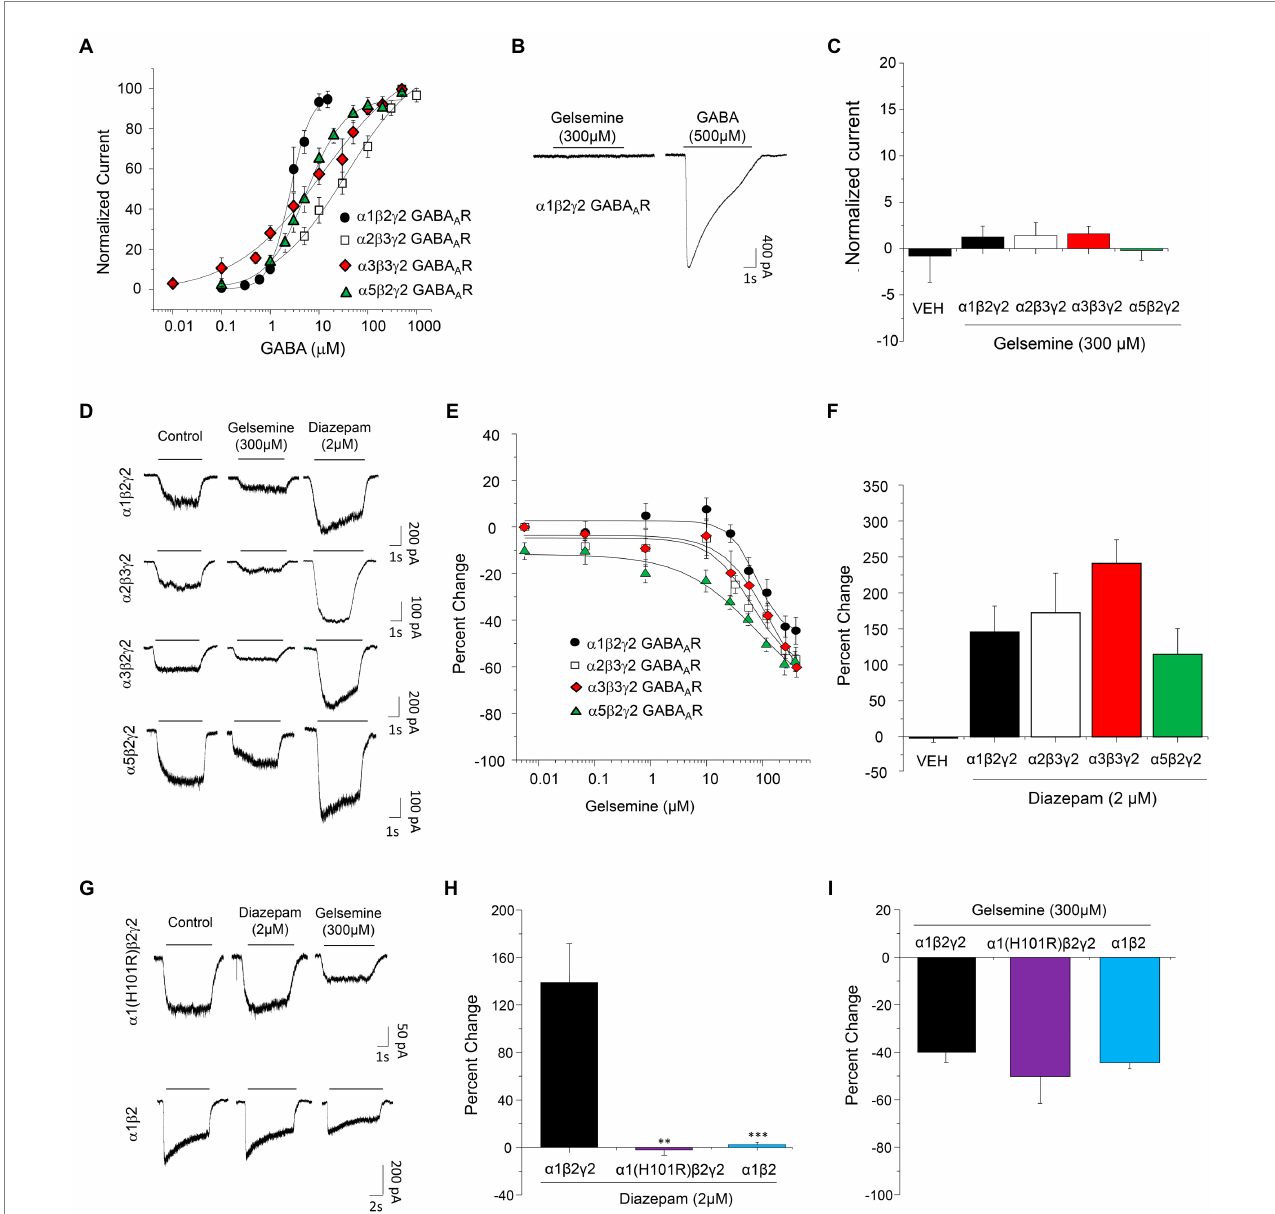
FIGURE 1 Modulation of recombinant BDZ-sensitive GABA A Rs by gelsemine. (A) Concentration-response curves to GABA of α 1 β 2 γ 2, α 2 β 3 γ 2, α 3 β 3 γ 2, and α 5 β 2 γ 2 GABA A Rs expressed in HEK293. Data points are means ± SEM from 6–8 cells. (B) Representative traces illustrating the actions of gelsemine in the absence of GABA on α 1 β 2 γ 2 GABA A Rs. (C) The graph summarizes the lack of detectable agonist effects of gelsemine on α 1 β 2 γ 2, α 2 β 3 γ 2, α 3 β 3 γ 2, and α 5 β 2 γ 2 GABA A Rs. Data are means ± SEM of 5–6 cells. (D) Representative traces showing the inhibitory effects of gelsemine (300 μ M) and the positive effects of diazepam (2 μ M) on GABA-evoked currents through α 1 β 2 γ 2, α 2 β 3 γ 2, α 3 β 3 γ 2, and α 5 β 2 γ 2 GABA A Rs. (E) The graph summarizes the effects of different gelsemine concentrations (0.1–300 μ M) on the GABA-evoked currents of cells expressing α 1 β 2 γ 2, α 2 β 3 γ 2, α 3 β 3 γ 2, and α 5 β 2 γ 2 GABA A Rs. (F) The graph shows the effects of diazepam (2 μ M) on the GABA-evoked currents. Data are means ± SEM of 5–10 cells. (G) Representative traces illustrating the effects of diazepam (2 μ M) and gelsemine (300 μ M) on GABA-evoked currents through α 1(H101R) β 2 γ 2 and α 1 β 2 GABA A Rs. (H,I) The graphs summarize the diazepam and gelsemine actions on α 1(H101R) β 2 γ 2 and α 1 β 2 GABA A Rs. For panel (H) , *** p < 0.001, ** p < 0.01, ANOVA followed by Bonferroni post-hoc test, F (2,14) = 3,860 . For panel (I) , differences were not significant. ANOVA followed by Bonferroni post-hoc test, F (2,14) =